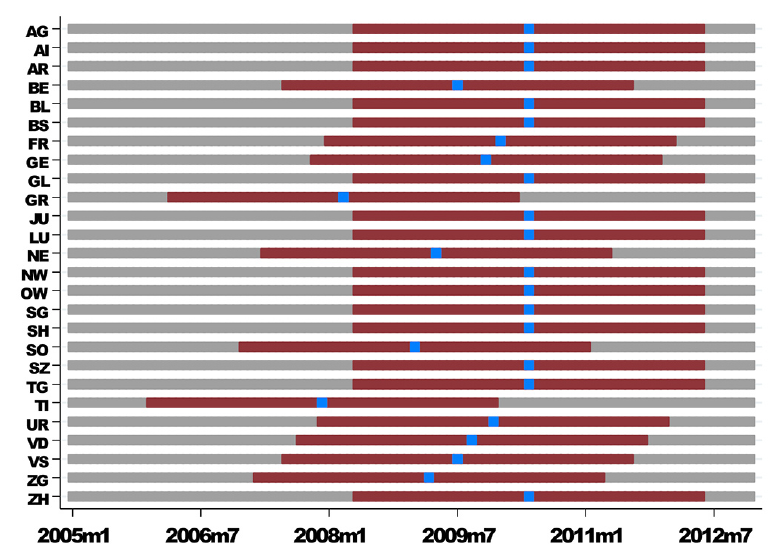
Figure S1 Scheme of the selection of the 2-year period before/after (red) the date of introduction of the smoking ban (blue) per canton. Canton abbreviations: Aargau (AG); Appenzell Innerrhoden (AI); Appenzell Ausserrhoden (AR); Bern (BE); Basel-Landschaft (BL); Basel- Stadt (BS); Fribourg (FR); Geneva (GE); Glarus (GL); Graubünden (GR); Jura (JU); Luzern (LU); Neuchâtel (NE);Nidwalden (NW); Obwalden (OW); St. Gallen (SG); Schaffhausen (SH); Solothurn (SO); Schwyz (SZ); Thurgau (TG); Ticino (TI); Uri (UR); Vaud (VD); Valais (VS); Zug (ZG); Zurich (ZH).